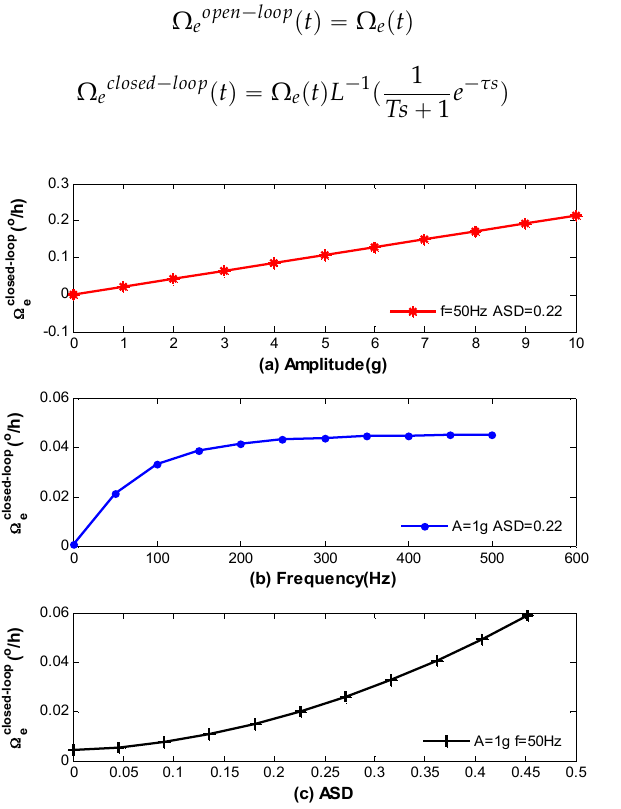
Figure 11. Standard deviation of vibration errors for closed-loop IFOG ( a ) Closed-loop errors versus amplitude; ( b ) Closed -loop errors versus frequency; ( c ) Closed -loop errors versus ASD.